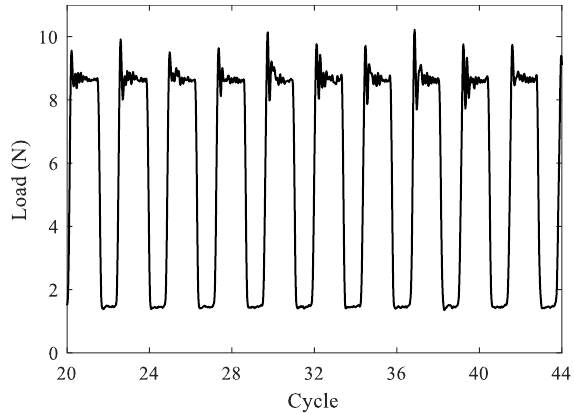
Figure 5. Example of output load of the loading device.